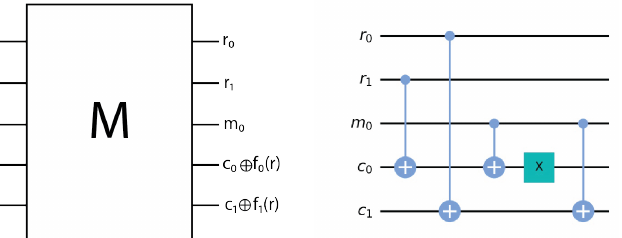
Figure 7. Motion block and its quantum circuit implementation. The quantum circuit is built